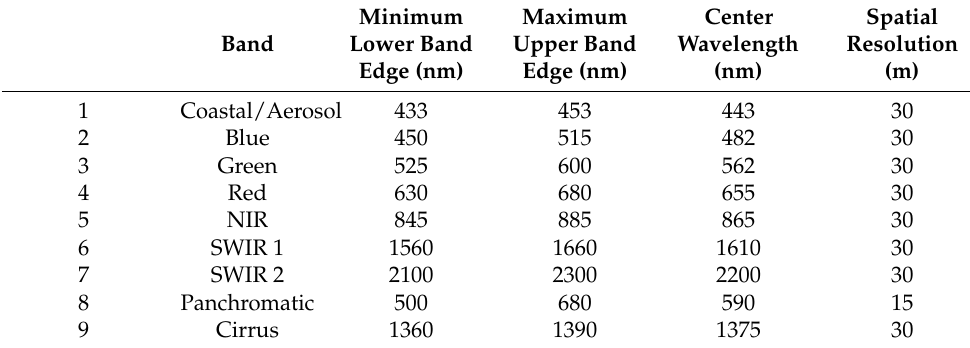
Table 1. Details about the OLI-2 spectral bands of Landsat